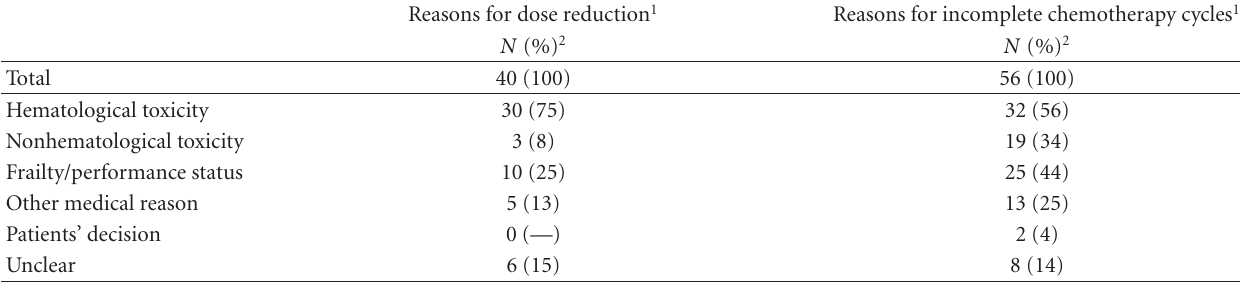
Table 4: Reasons for dose reduction and not completing chemotherapy.